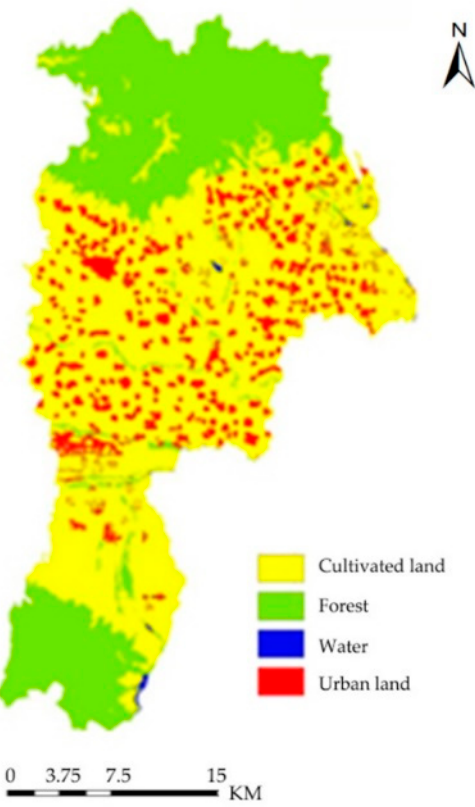
Figure 8. Simulation of land use map in 2020 based on the LCM model.